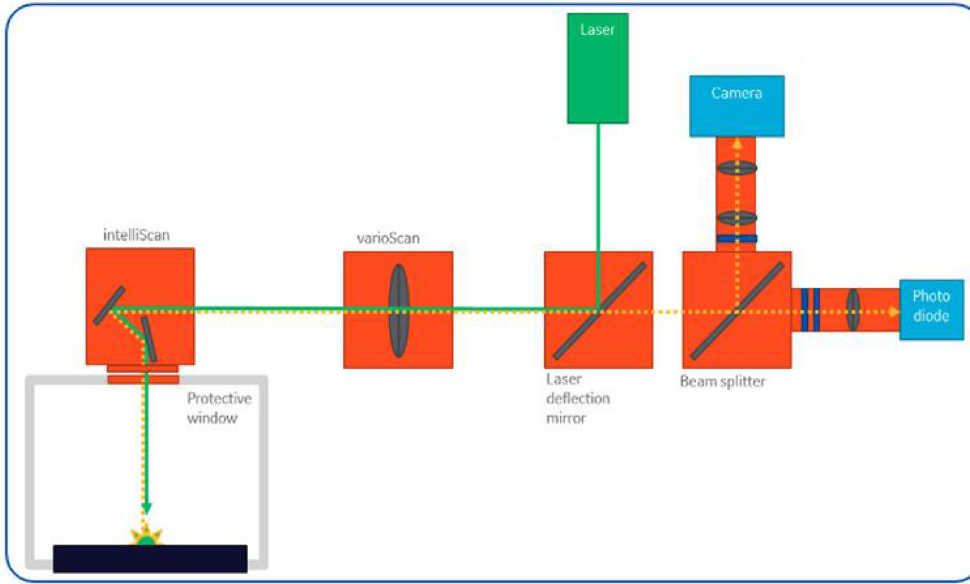
Figure 1. Schematic of a representative setup used in the experiments. The photodiode is used as the primary sensor to evaluate the emission spectra (the camera was not used in the results reported